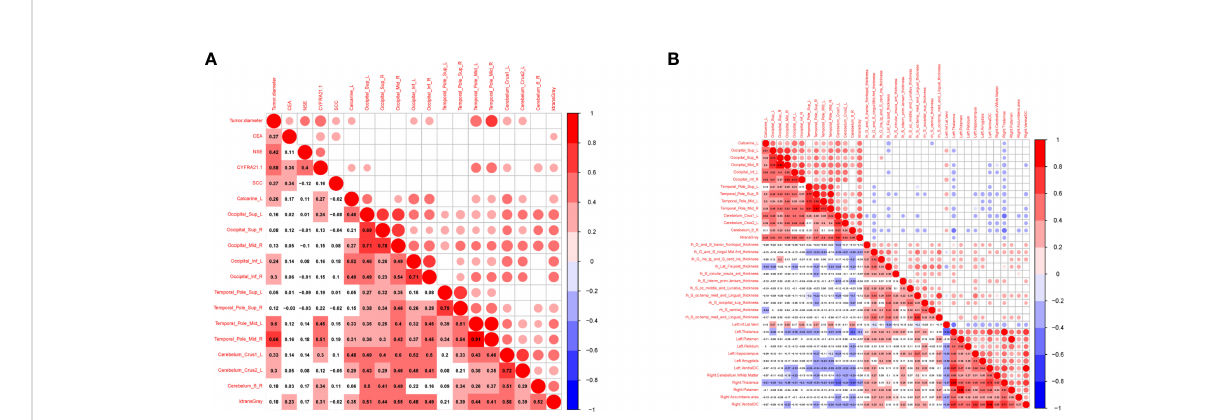
FIGURE 5 Correlation between tumor markers, differential cerebral cortical thickness, subcortical volume and BBB leakage in patients with LC. Red represents positive correlation, blue represents negative correlation, the darker the color, the higher the correlation. (A) Showed the correlation between tumor markers, tumor diameter and BBB leakage in LCs (n=75). (B) Showed the correlation between cerebral cortical thickness, subcortical volume and BBB leakage in LCs and HCs